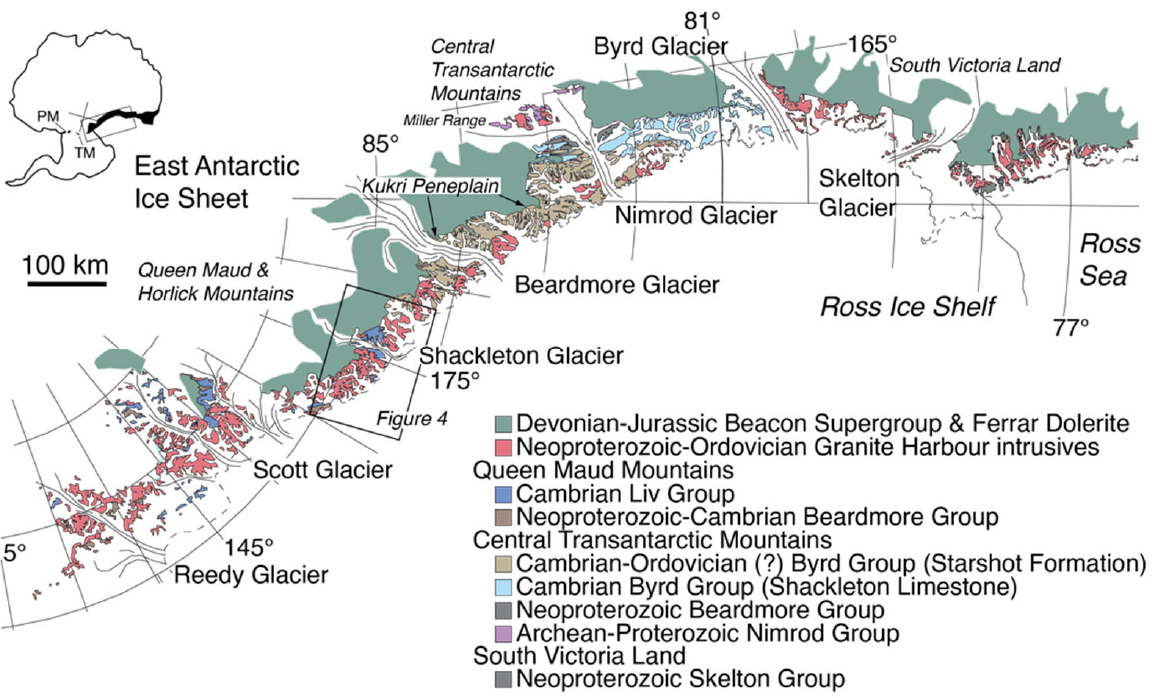
Figure 2. Simplified geologic map showing intrusive, volcanic, sedimentary, and metamorphic basement rocks of the Ross orogen and unconformably overlying Beacon Supergroup from the south Victoria Land to the south through the Queen Maud and Horlick mountains. There are abundant volcanic rocks in the early to middle Cambrian stratigraphic packages (i.e., the Liv Group) in the Queen Maud Mountains, whereas the early to middle Cambrian stratigraphic packages (i.e., the Byrd group) in the central Transantarctic Mountains are practically devoid of volcanic rocks. The boundary separating the Liv Group from the Byrd Group occurs west of Shackleton Glacier. Inset shows the location of the Transantarctic Mountains (the black area is the Ross orogen). Abbrevia- tions: PM, Pensacola Mountains; TM, Thiel Mountains. Figure compiled and modi fi ed from others [16–20].